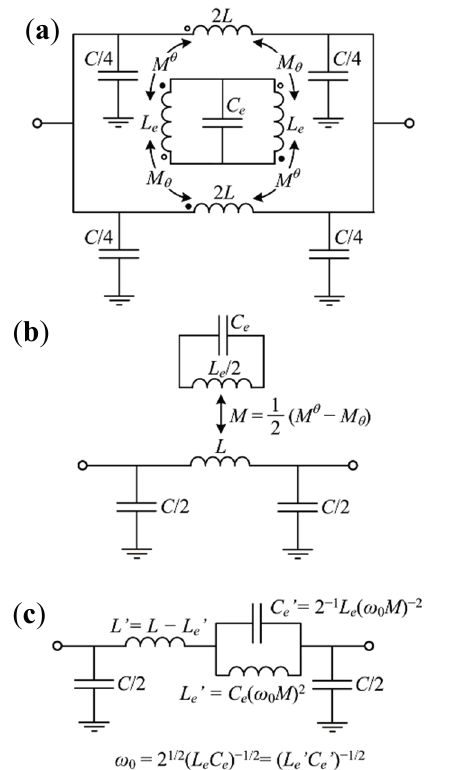
Figure 10. ( a ) Equivalent circuit model of a CPW loaded with an ELC resonator, including the different magnetic coupling mechanisms, accounted for through the mutual inductances M θ and M θ ; ( b ) simplified circuit model; ( c ) transformed simplified circuit